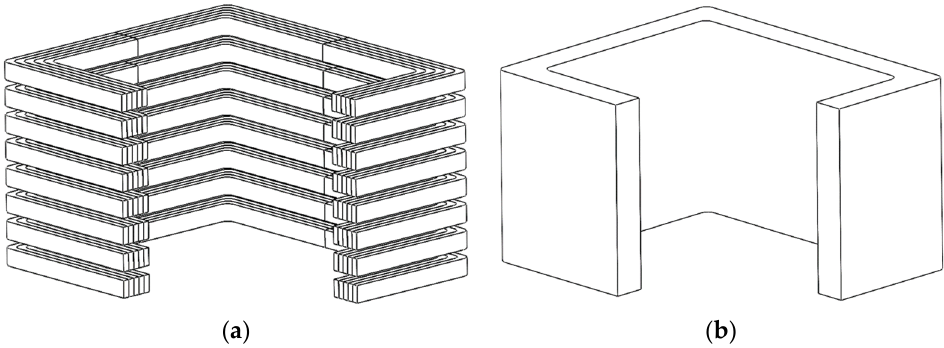
Figure 4. Grid side winding model. ( a ) Interleaved windings; ( b ) Continuous windings.